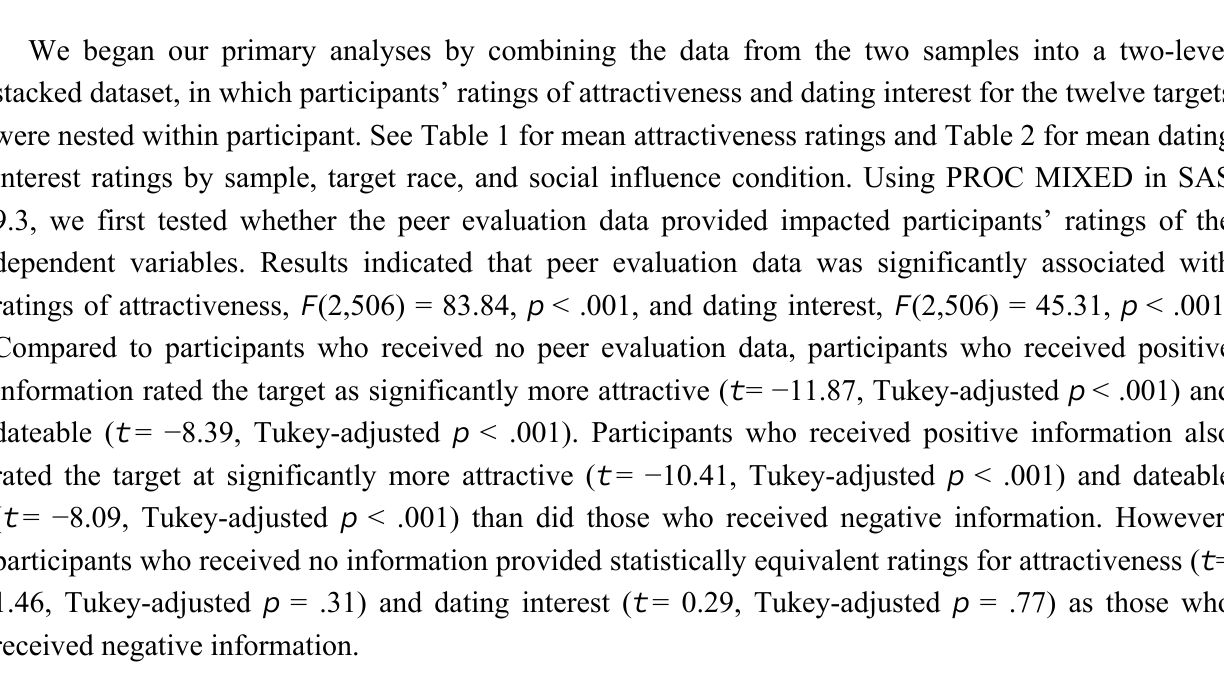
Table 1. Mean attractiveness ratings by type of peer evaluation data, target race, and sample.